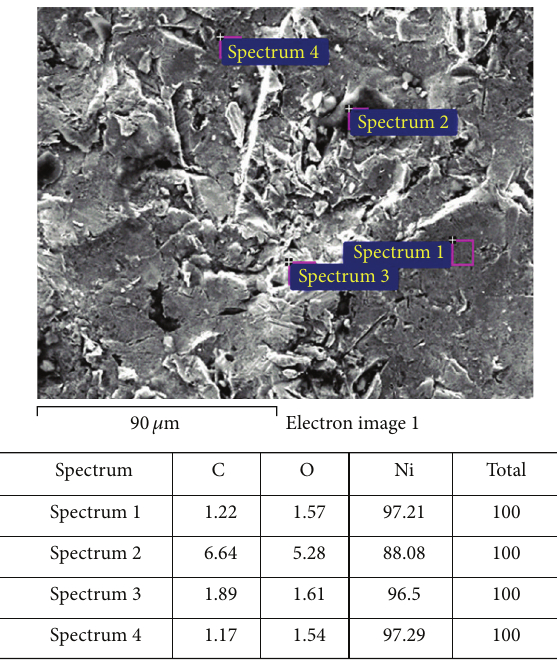
Figure 2: SEM/EDS of the pure Ni sheet after corrosion tests in 0.1M NaCl temperature.